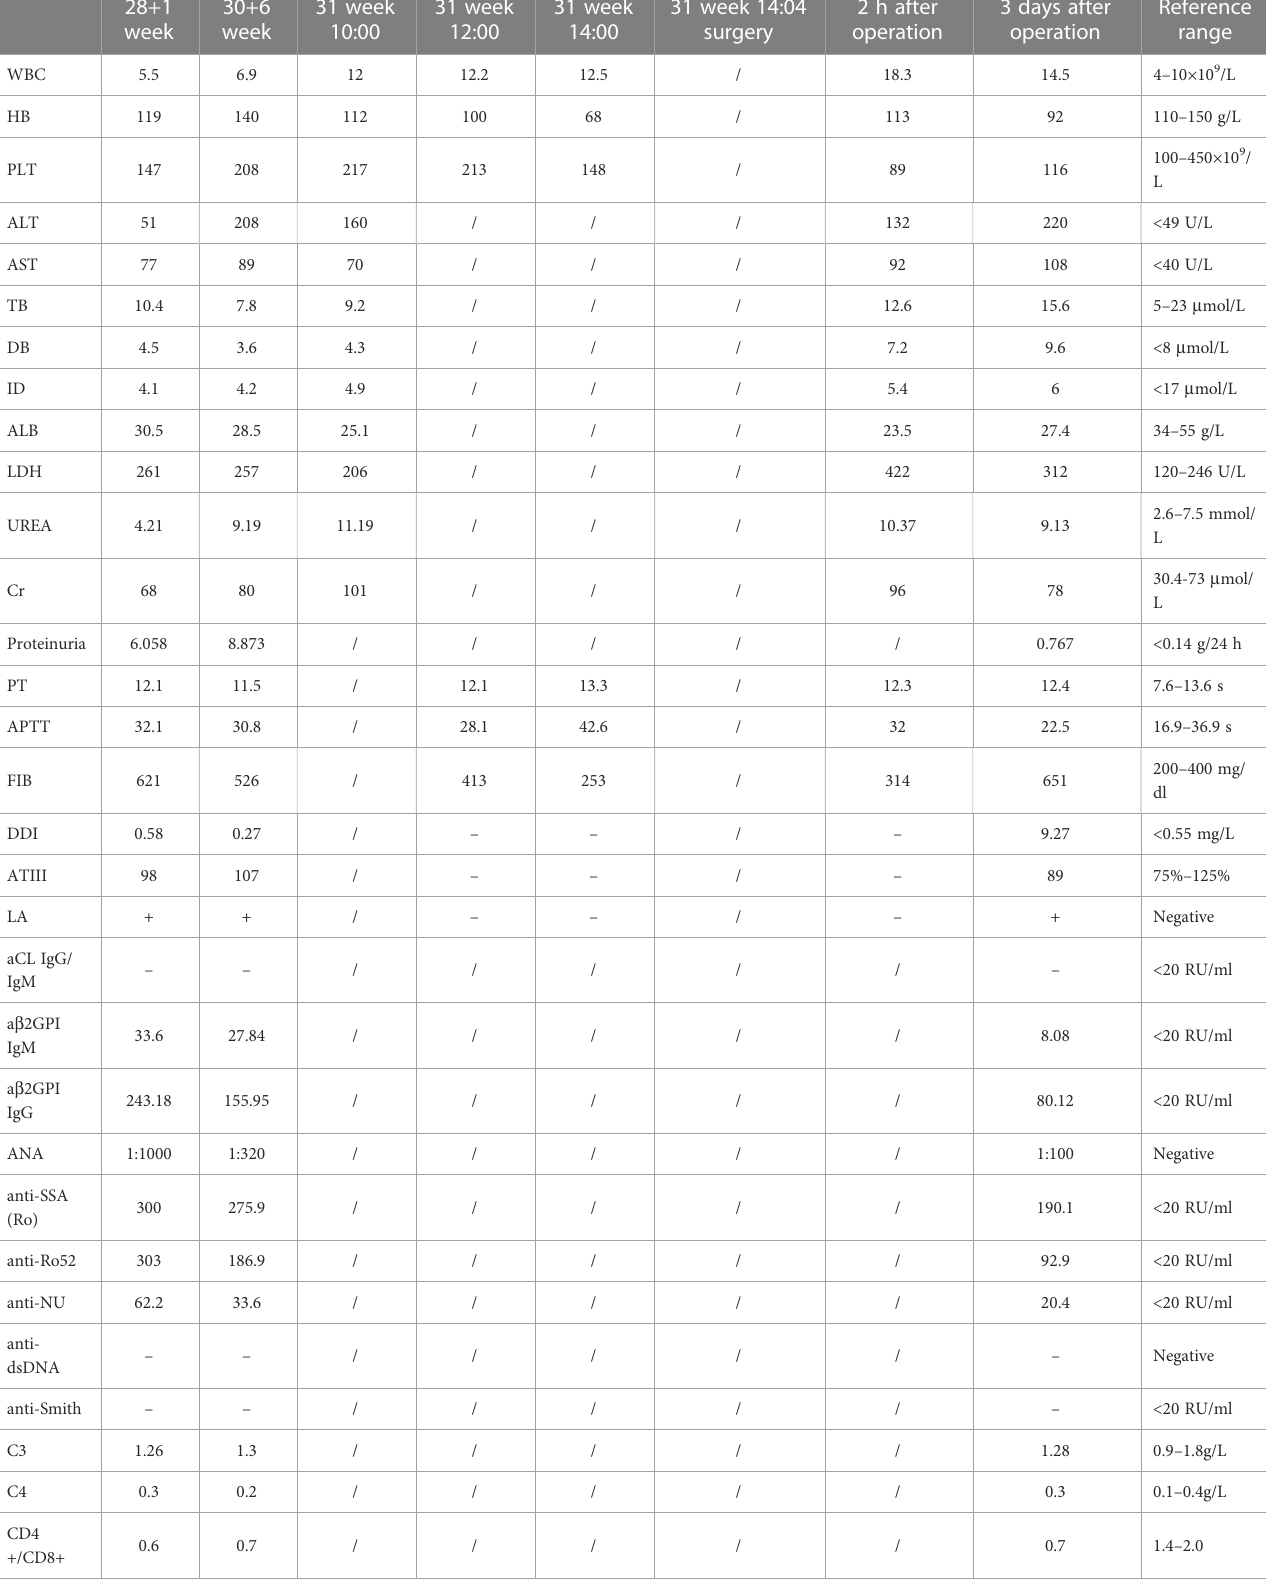
TABLE 2 Case 1 laboratory evolution during